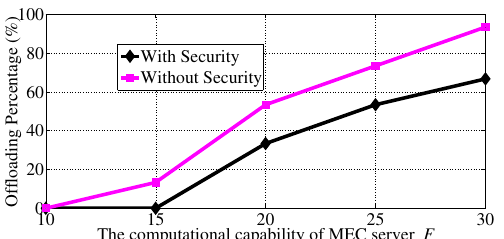
Figure 7. The offloading percentage of IoTD users versus different computational capacities of MEC